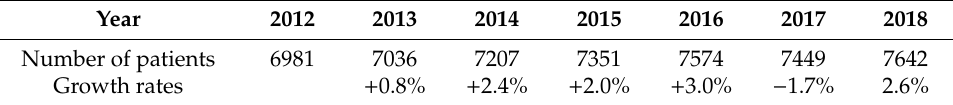
Table 1. Growth rates of the population treated in Ile-de-France for metastatic